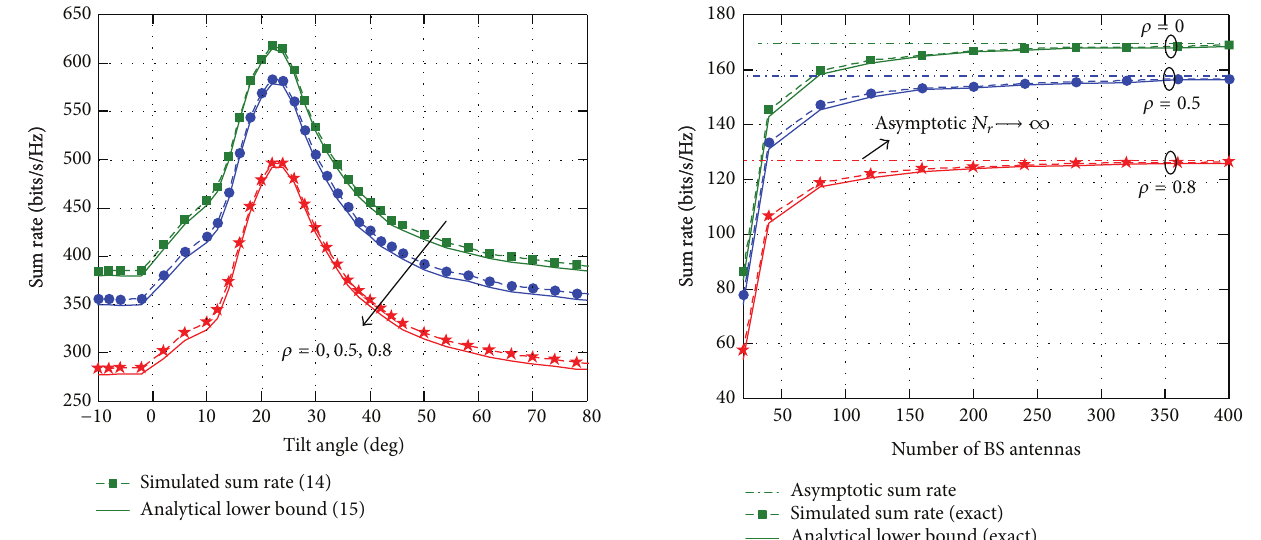
Figure 4: Simulate sum rate and lower bound versus tilt angle ( 𝛾 = 20 dB, 𝑁 𝑟 = 50 , 𝑁 𝑡 = 2 , 𝐾 = 18 , 𝜌 = 0,0.5, 0.8 ).